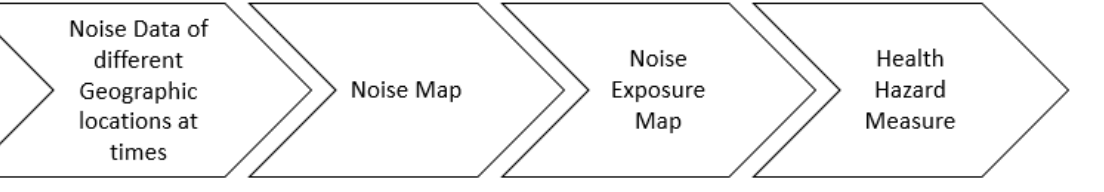
Figure 6. Noise pollution reflected in a noise map. The noise map relates with the noise exposure map and the noise exposure level relates with hazards to health.